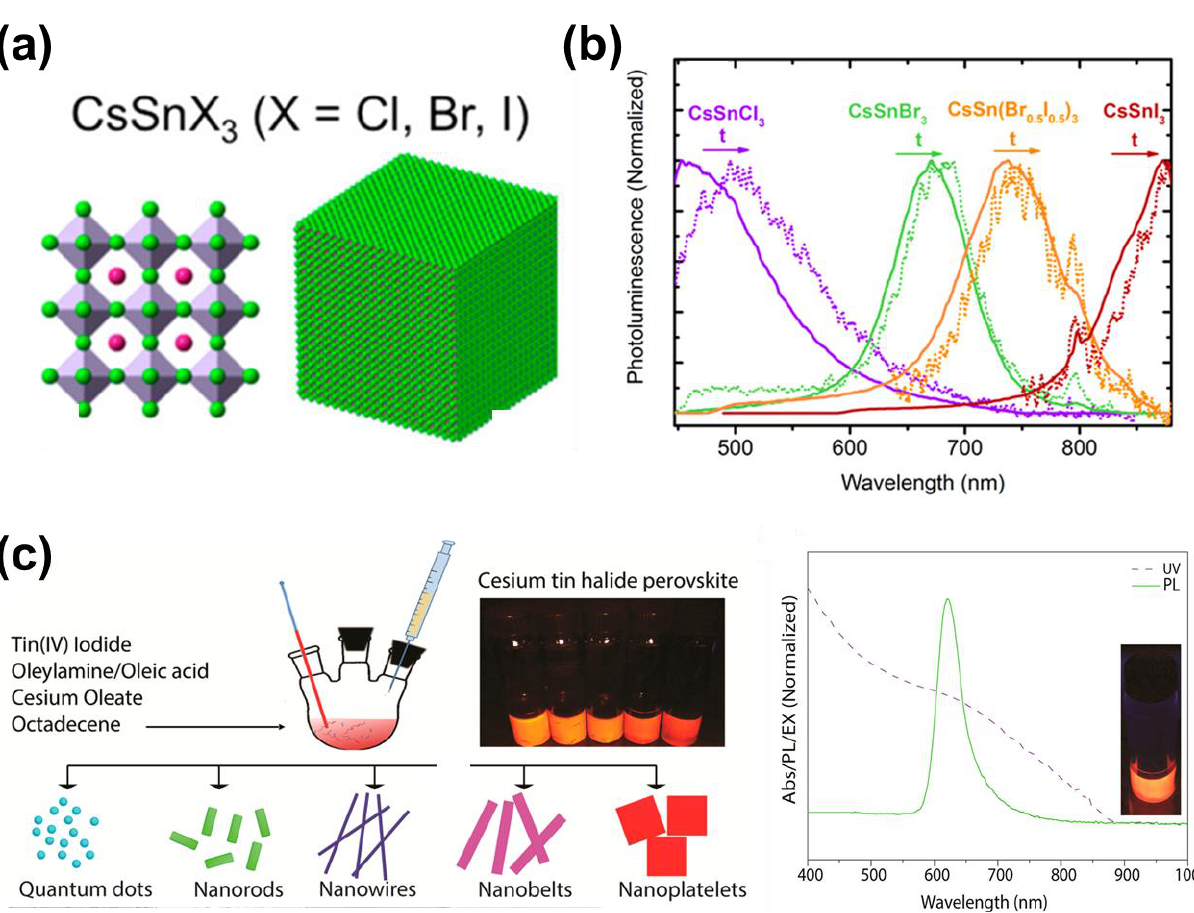
Figure 19. ( a ) The schematic of CsSnX 3 and PL of as-synthesized CsSnX 3 (X = Cl, Br, Br 0.5 I 0.5 , I) perovskite nanocrystals in solution after an ultrashort excitation (<ps) at 400 nm. The colored solid lines represent the integrated PL from 0 to 5 ns for each sample. Dashed lines are the integrated PL at time-slices of 30–60 ns (CsSnCl 3 ), 5–8 ns (CsSnBr 3 ), 30–50 ns (CsSn(Br 0.5 I 0.5 ) 3 ), and 8–30 ns (CsSnI 3 ). [99] Copyright 2016 American Chemical Society. ( b ) Fast (inset) and slow PL decay kinetics of as-synthesized and aged CsSnBr 3 nanocrystals in solution, excited at 490 nm and detected at 590–900 nm [99]. Copyright 2016 American Chemical Society. ( c ) Schematic of the controlled synthesis of perovskite Cs 2 SnI 6 nanocrystals and the UV-vis absorption and PL emission spectra of perovskite Cs 2 SnI 6 nanocrystals. [100] Copyright 2016 American Chemical Society.